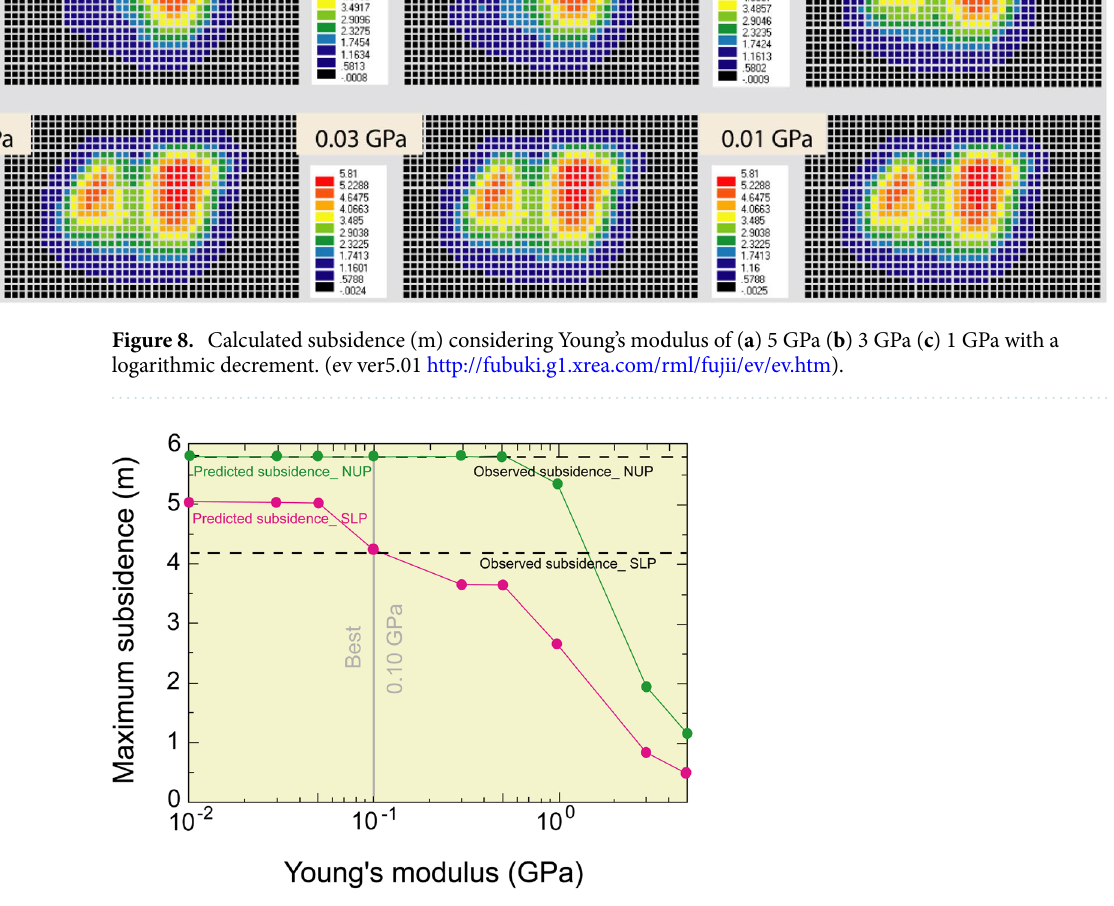
Figure 9. Young’s modulus effect in the predicted